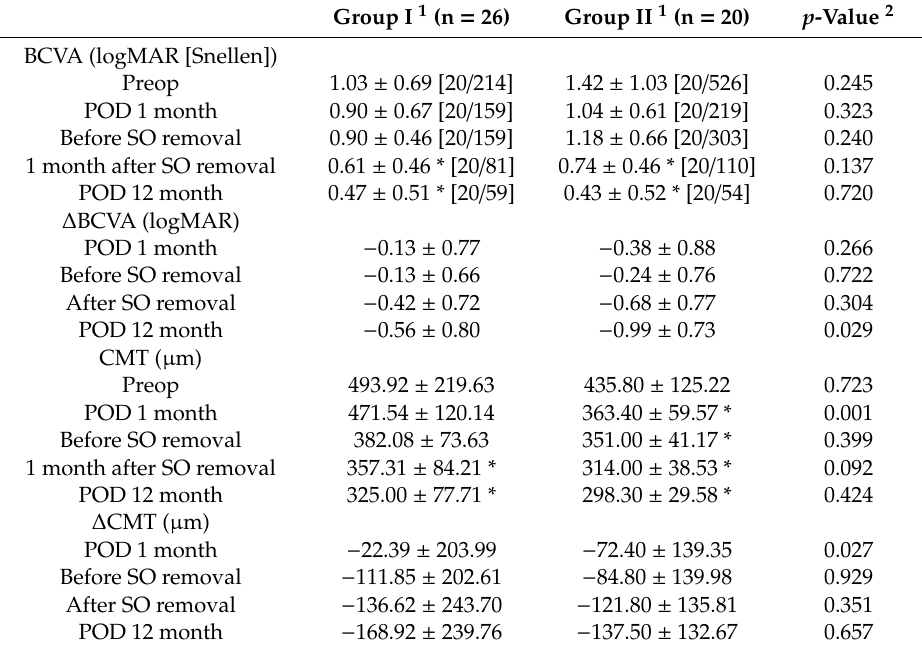
Table 2. Between-Group Comparisons of Postoperative Clinical